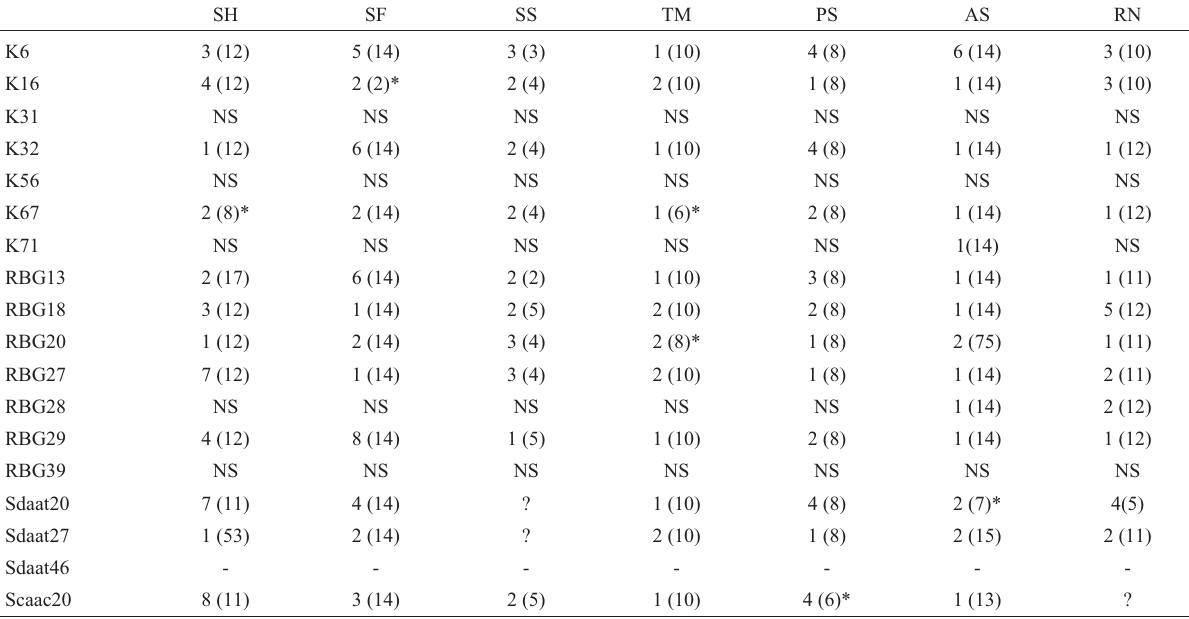
Table 1 - Number of alleles found in each species of seabird for each primer combination. The number of individuals tested is shown in brackets. SH